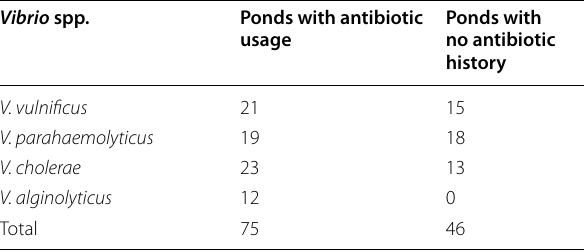
Table 3 Frequency of occurrence of Vibrio species in the aquaculture ponds